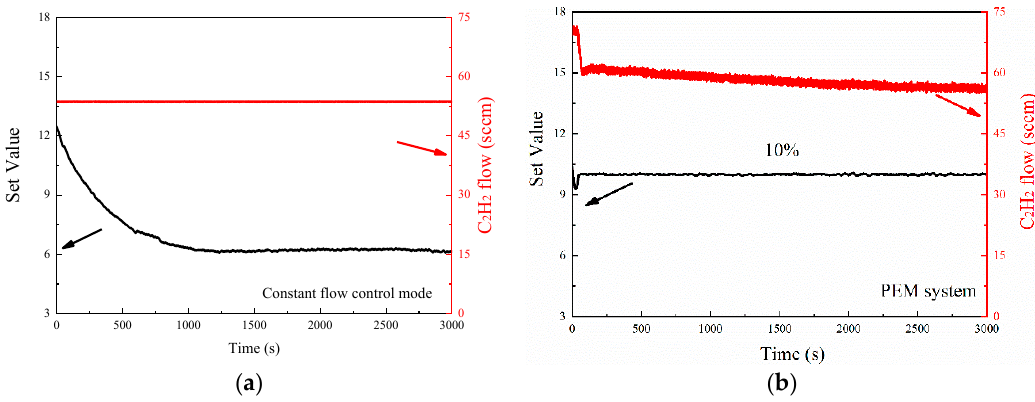
Figure 3. Experimental time-dependent emission intensity of Cr atom and C 2 H 2 flow rate under ( a ) constant flow control mode and ( b ) plasma emission monitoring (PEM) system at a set value of 10%. The 0 s is the time of setting the C 2 H 2 gas flow rate for constant flow control and set value for the PEM system.